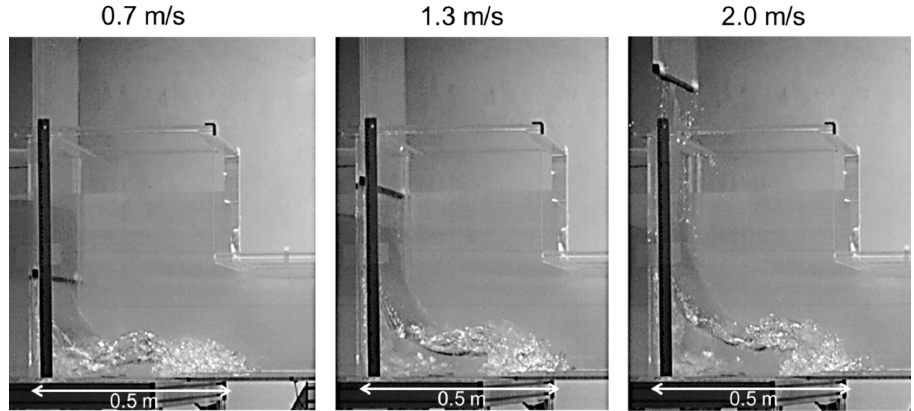
Figure 6. Water jet 0.3 s after opening the gate for three different gate speeds.